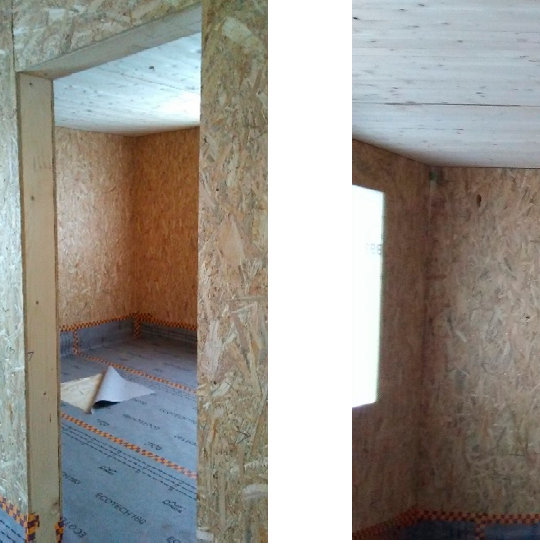
Figure 2. Pictures of the internal partition.